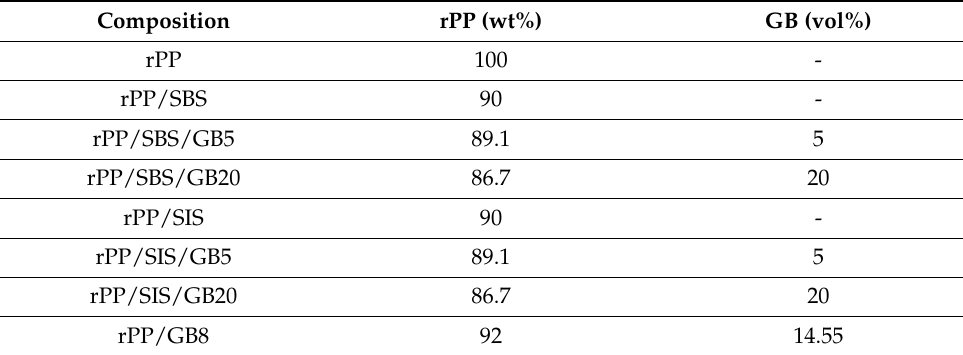
Table 1. Compositions for recycled polypropylene (rPP) composites [28,58].